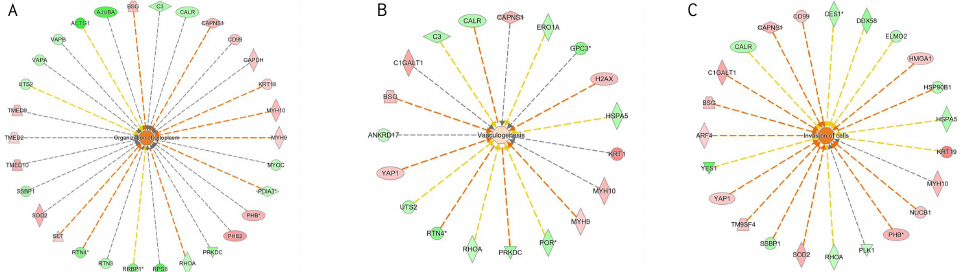
Figure 8. Positively induced pathways (orange hubs) in NAFLD versus control cells: ( A ) organization of cytoplasm, ( B ) vasculogenesis, and ( C ) invasion of cell pathway. The * indicates the presence of